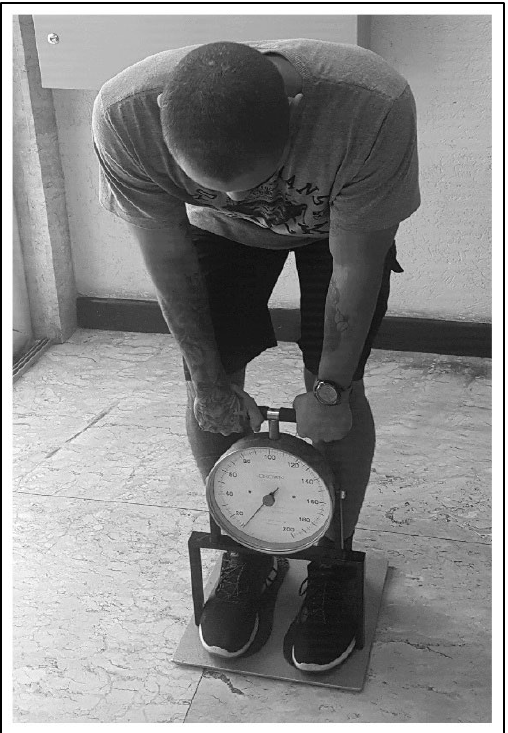
Figure 1. Illustration of the isometric lumbar strength test.